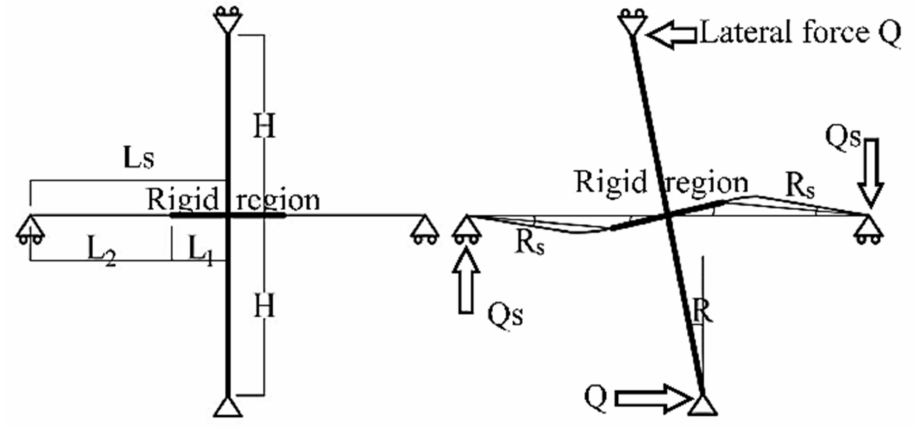
Figure 7. The effective beam at the wall-slab joints in TWTS